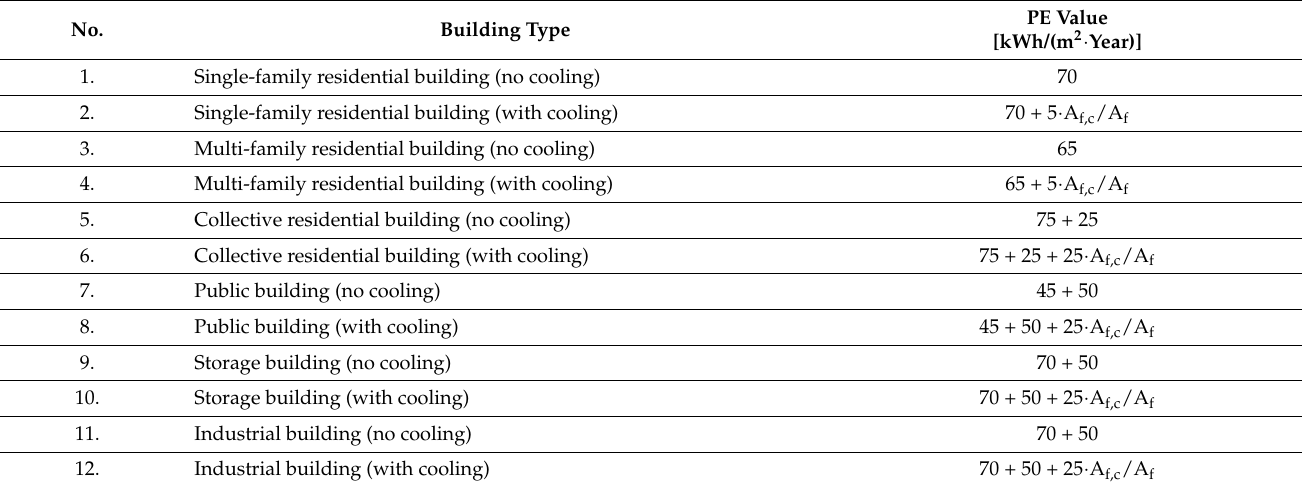
Table 1. Maximum values of demand for non-renewable primary energy in Poland